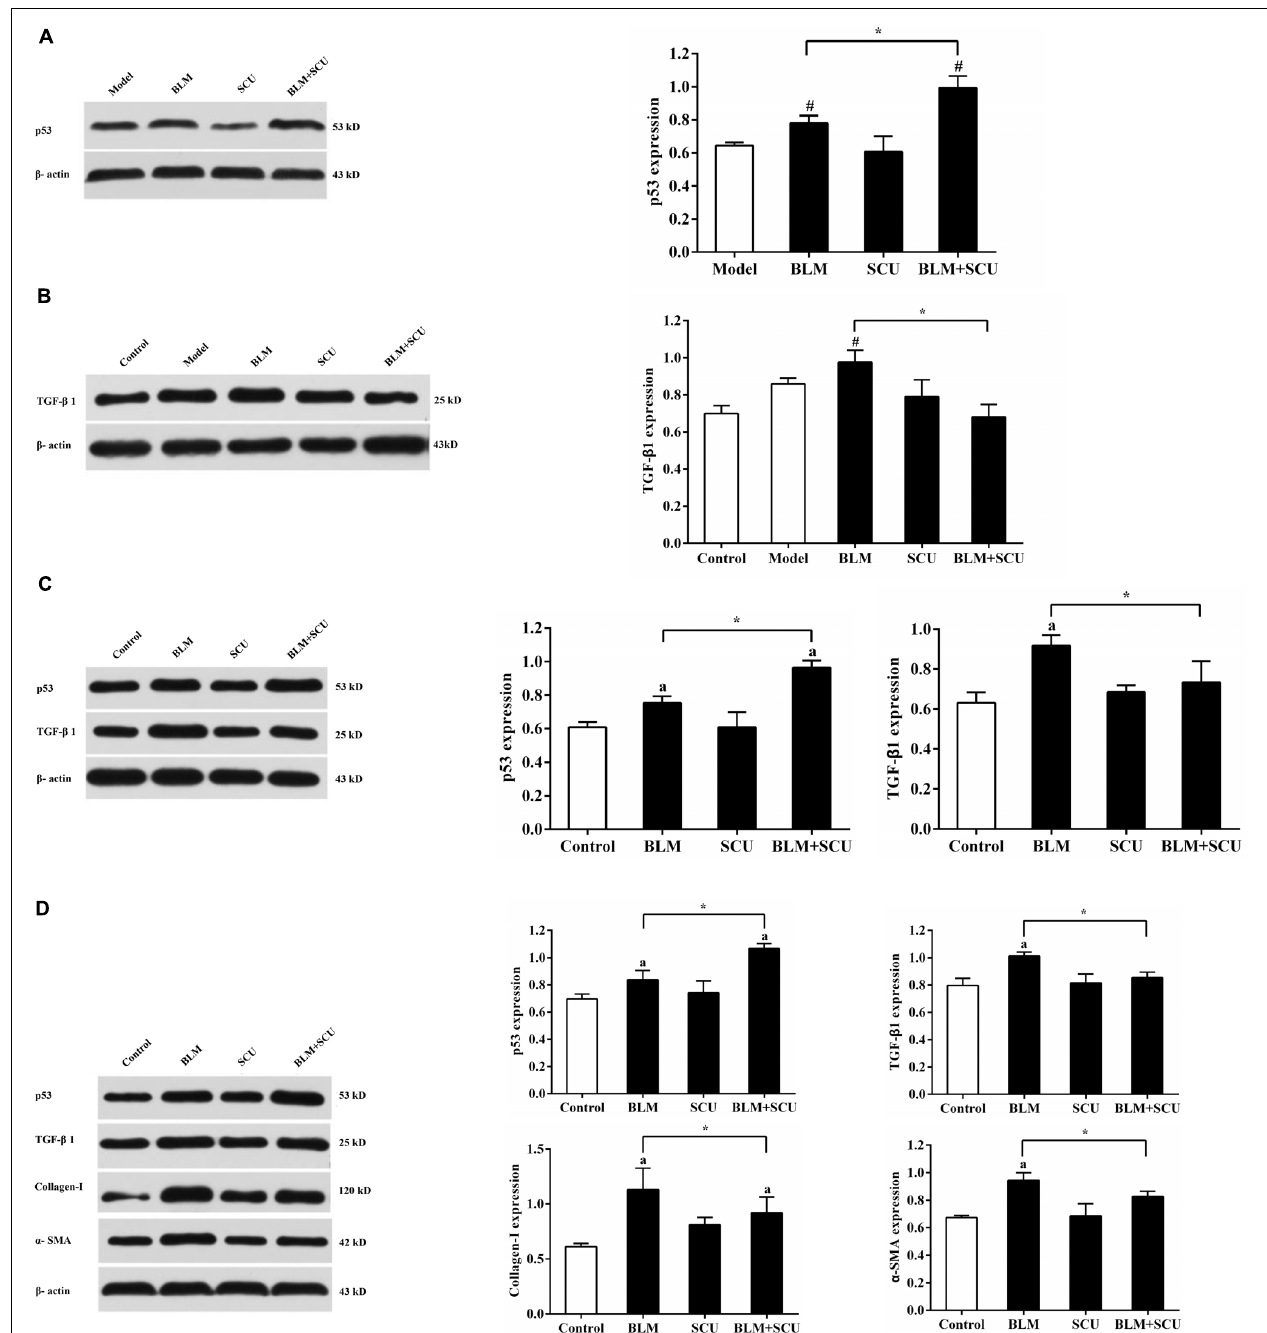
FIGURE 10 | Effects of BLM, SCU, and their combination on the expression p53, TGF- β 1 collagen-I and α -SMA. The representative images about protein expressions of p53, TGF- β 1, collagen-I, α -SMA, and β -actin were measured by Western blot. (A) The expression of p53 in ascites. (B) The expression of TGF- β 1 in lung tissues. (C) The expression of p53 and TGF- β 1 in H22 cells. (D) The expression of p53, TGF- β 1, collagen-I, and α -SMA in MRC-5 cells. Data are shown as the mean ± SD. ( n = 3). # p < 0.05 compared with model group; ∗ p < 0.05 compared with BLM group; a < 0.05 compared with control